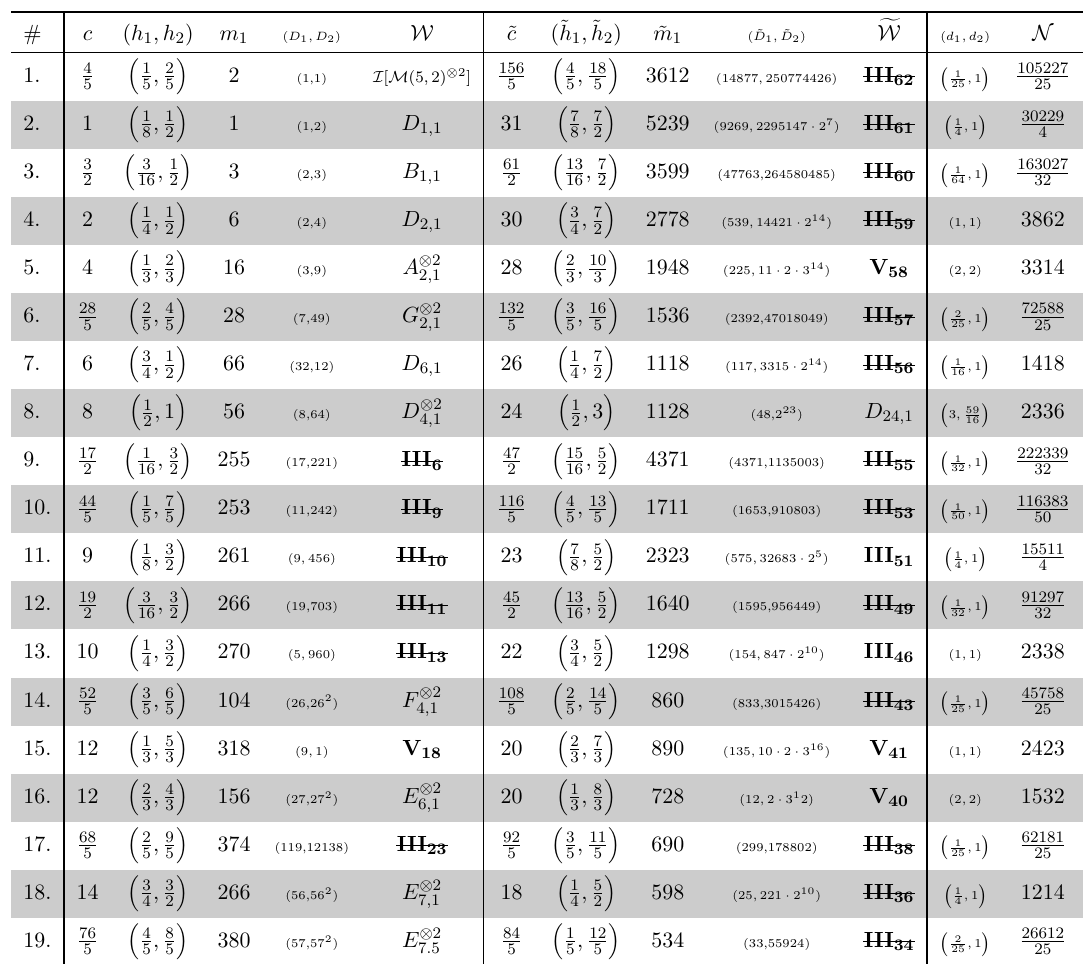
Table 13. Inconsistent pairings, c H = 32 with ( n 1 , n 2 ) = (1 , 4) . The integer N in the last